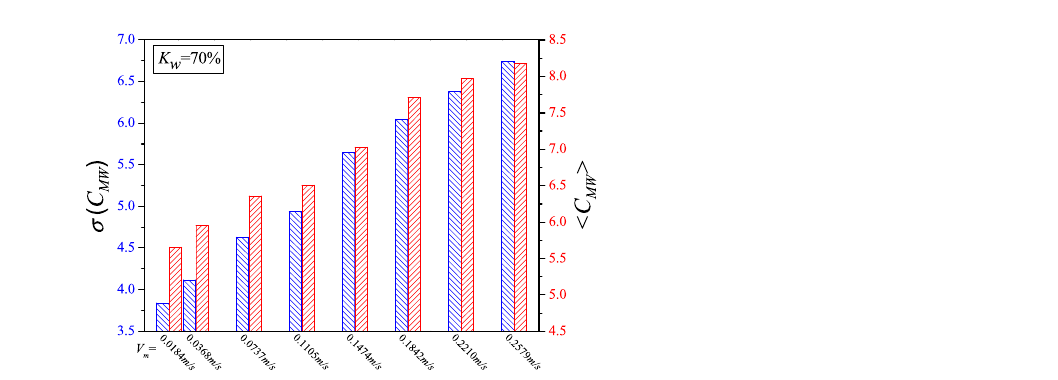
Figure 5. < C MW > and σ ( C MW ) for flow conditions with different total flow velocities ( V m ) when water-cut K w = 60%.